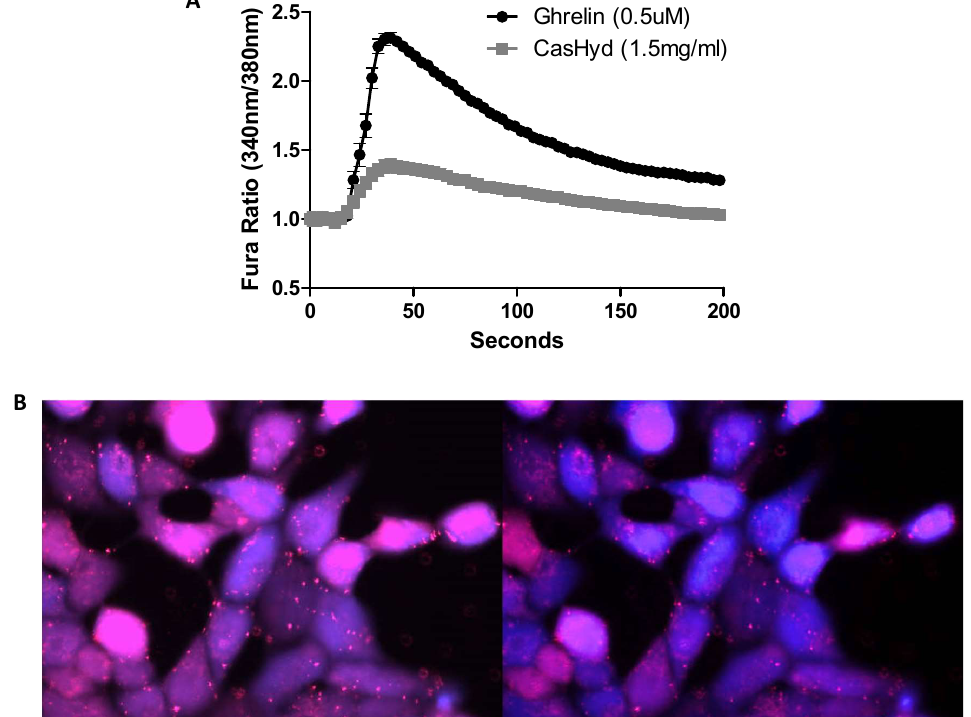
Figure 2. Specific activation of heterologously expressed GHSR-1a in HEK293A cell line. ( A ) Calcium imaging of human embryonic kidney (HEK) cells heterologously expressing the GHS-R1a. Cells were seeded for 48 h into wells at a density of 2.0 × 10 5 cells/mL, and loaded for 1 h with the UV-excitable fluorescent calcium indicator, Fura-2AM, and the 340 nm/380 nm ratio was recorded after addition of 500 nM ghrelin or 1.5 mg/mL CasHyd. ( B ) Calcium influx is evident through the shift in fluorescence from pink to blue (40× magnification). Traces represent the average of three independent experiments, error bars are indicative of SEM.